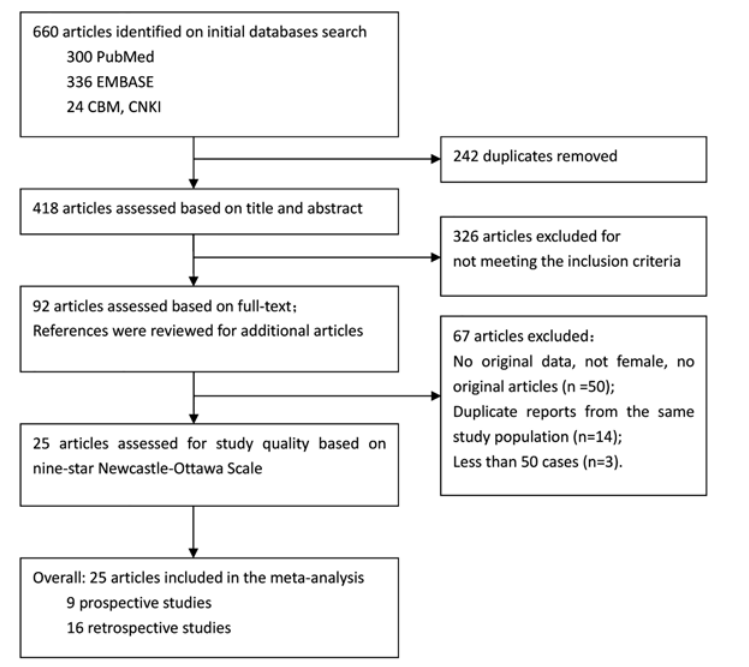
Fig 1. Flowchart for study